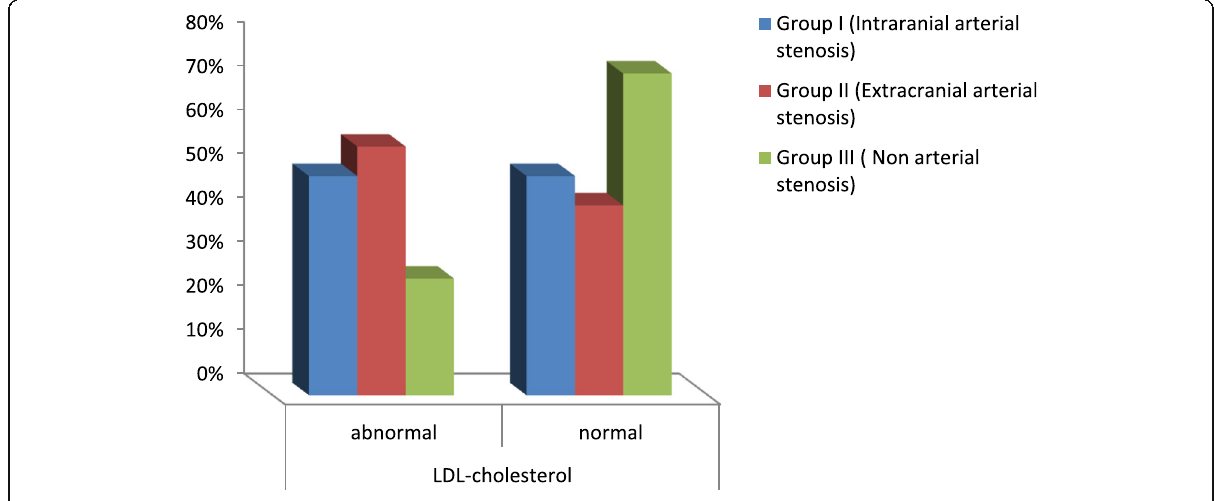
Fig. 1 Comparison of serum LDL cholesterol between groups I, II, and